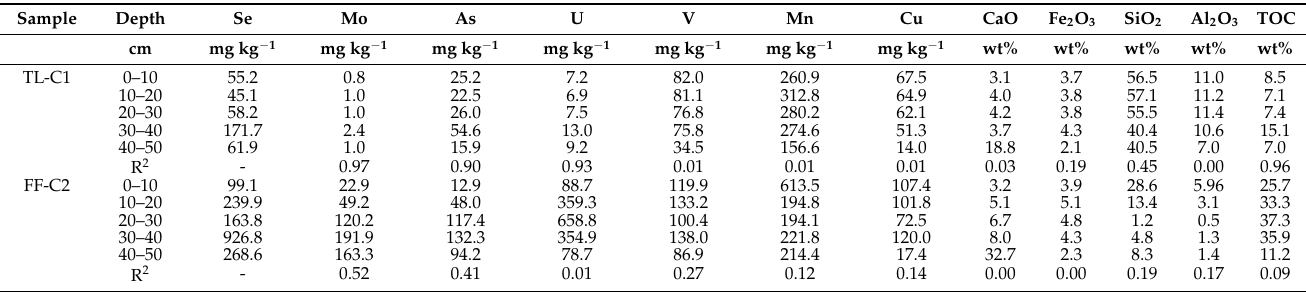
Table 2. XRF data showing the concentration of selected trace and major elements for two soil cores, TL-C1 and FF-C2. R 2 = the correlation with selenium. TOC = total organic carbon.